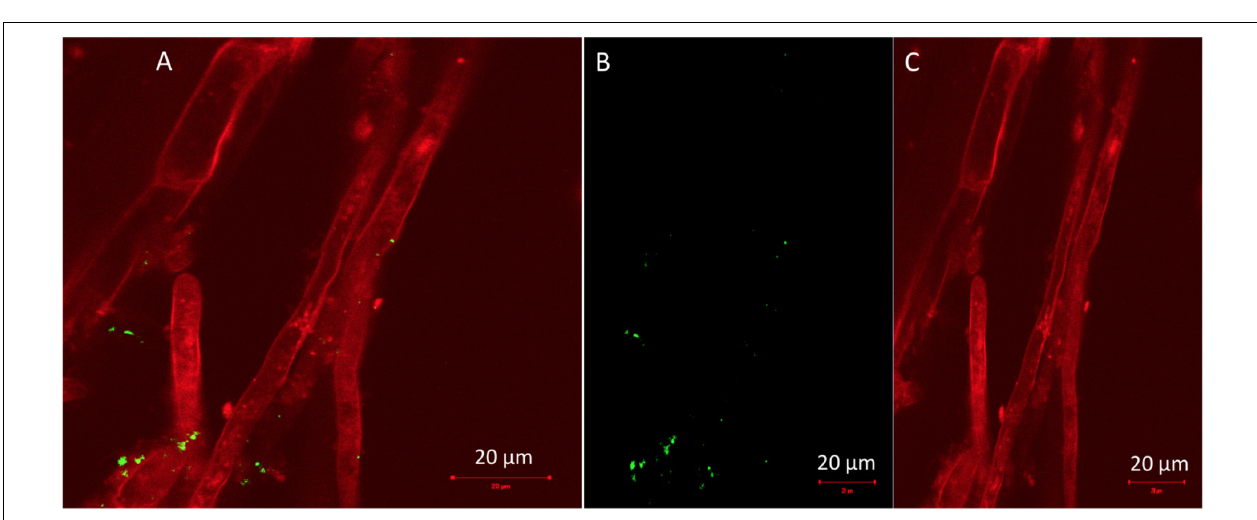
FIGURE 5 | Confocal laser scanning micrographs of (A) gfp-tagged B3 strain colonizing roots of Juncus acutus , (B) solution with live gfp-labeled B3 bacteria, and (C) root tissue